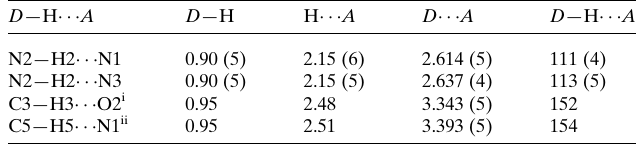
Table 1 Hydrogen-bond geometry (A˚ , (cid:2) ) for 1